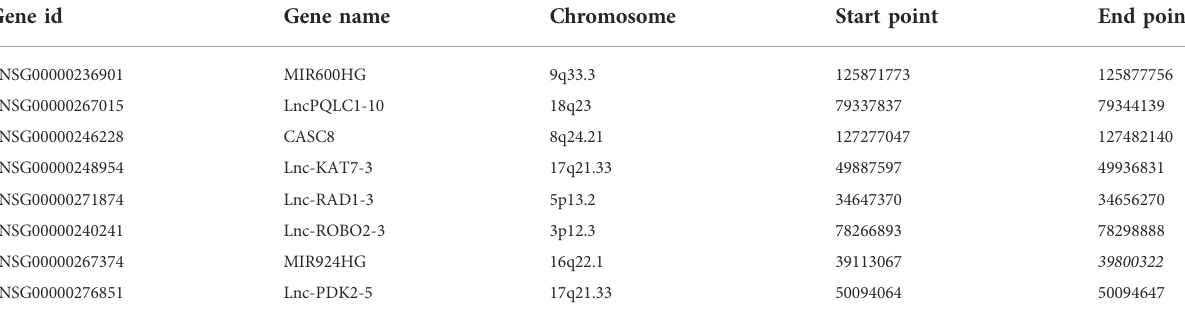
TABLE 1 Information of the lncRNAs in pancreatic cancer prognostic signature. 8 lncRNA-based molecular classi fi